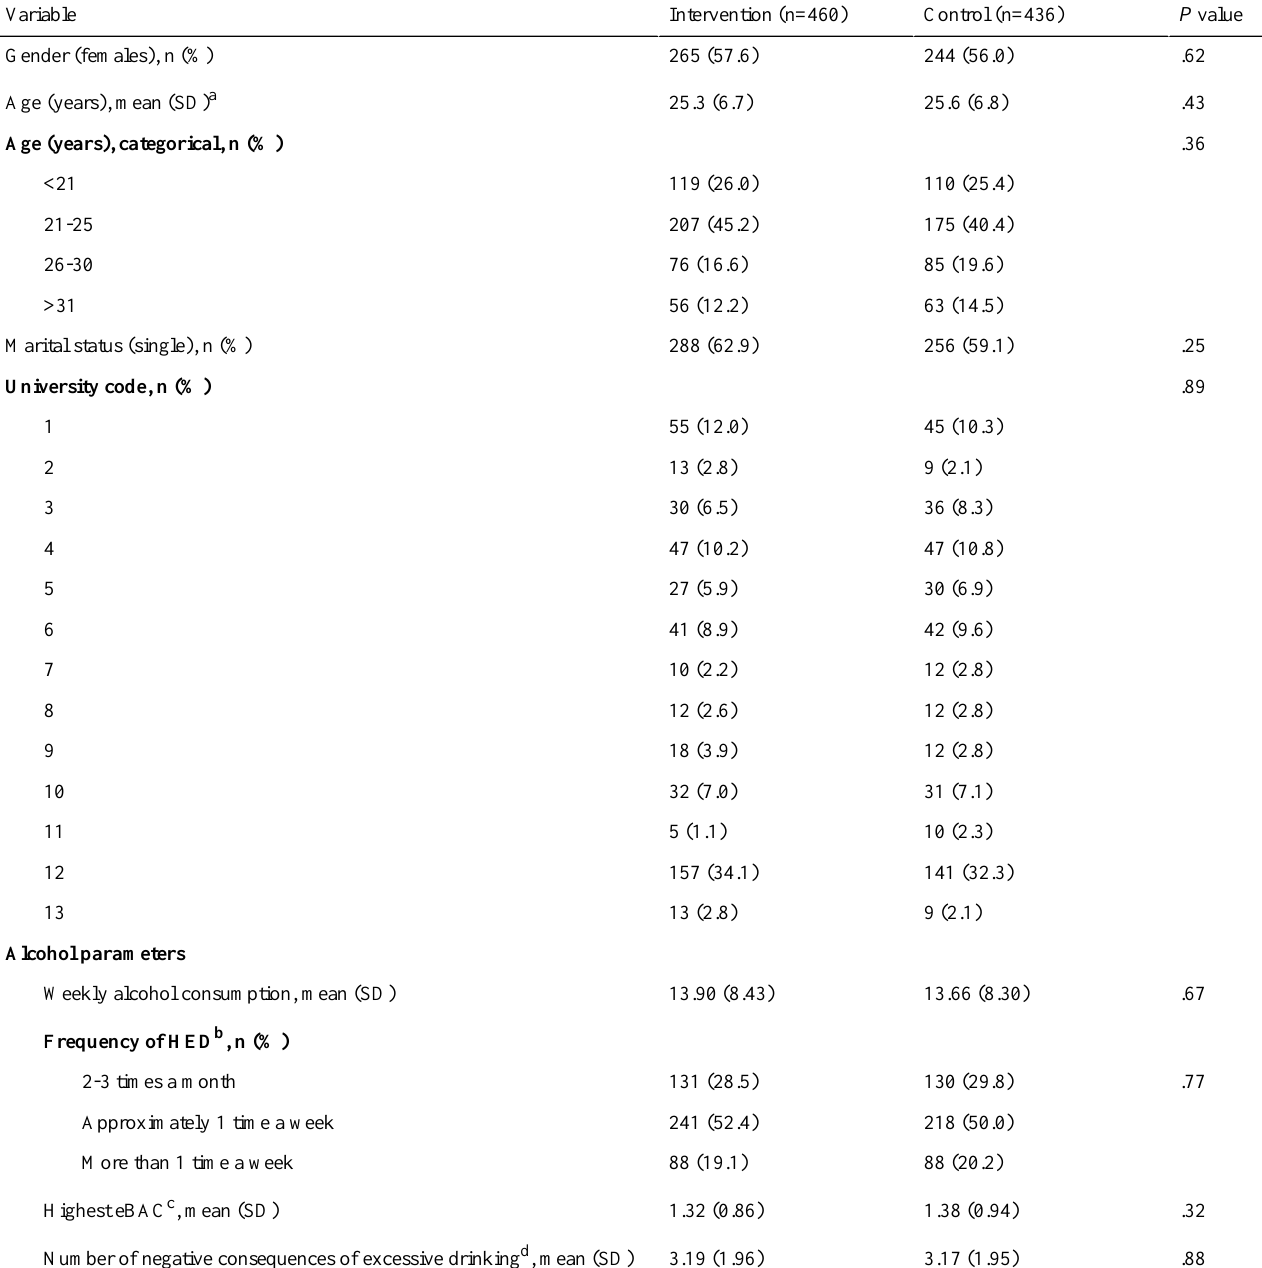
P valueControl (n=436)Intervention